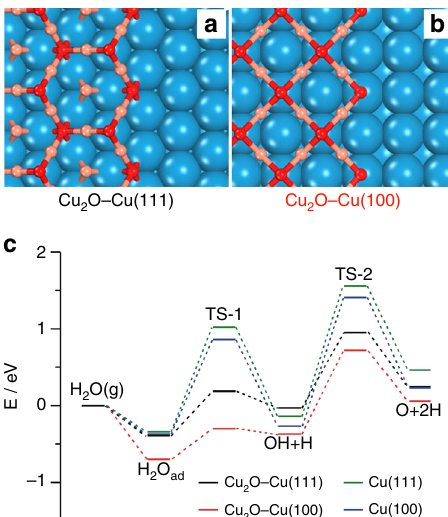
Fig. 5 DFT calculations. Schematic a Cu 2 O – Cu(111) and b Cu 2 O – Cu(100) interface structures. Blue , orange , and red balls represent Cu, Cu of Cu 2 O, and O atoms, respectively. c Calculated energy diagram of water adsorption and decomposition on Cu 2 O – Cu(111), Cu 2 O – Cu(100), Cu(111), and Cu(100)